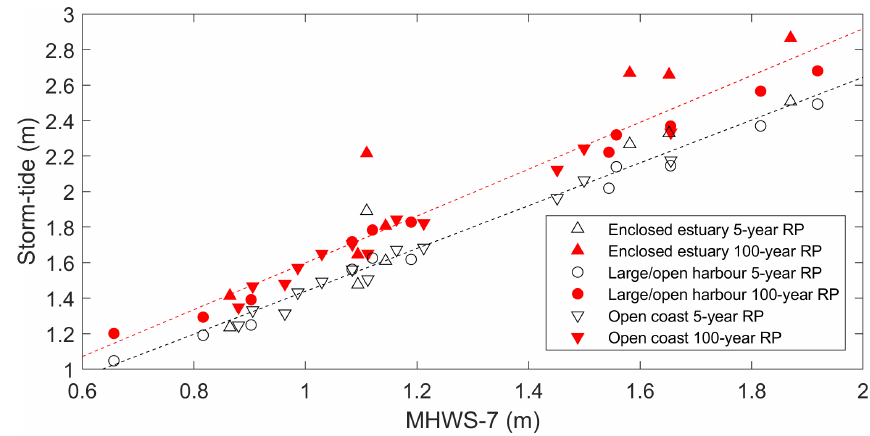
Figure 4. Linear relationship between high tide and storm tide in NZ. MHWS-7 is the height equalled or exceeded by the highest 7% of all high tides. RP denotes return period, also known as average recurrence